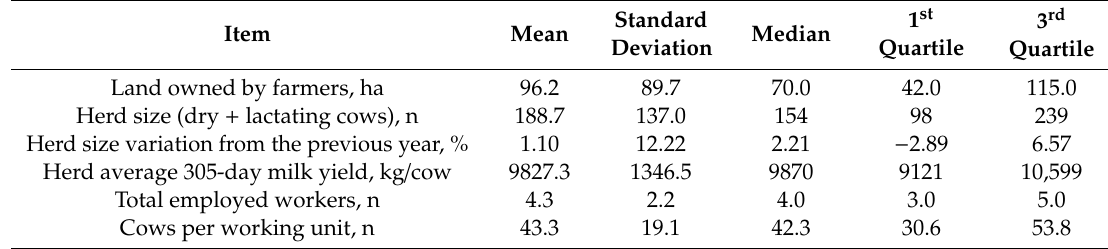
Table 1. Descriptive statistics of the 490 dairy farms involved in the